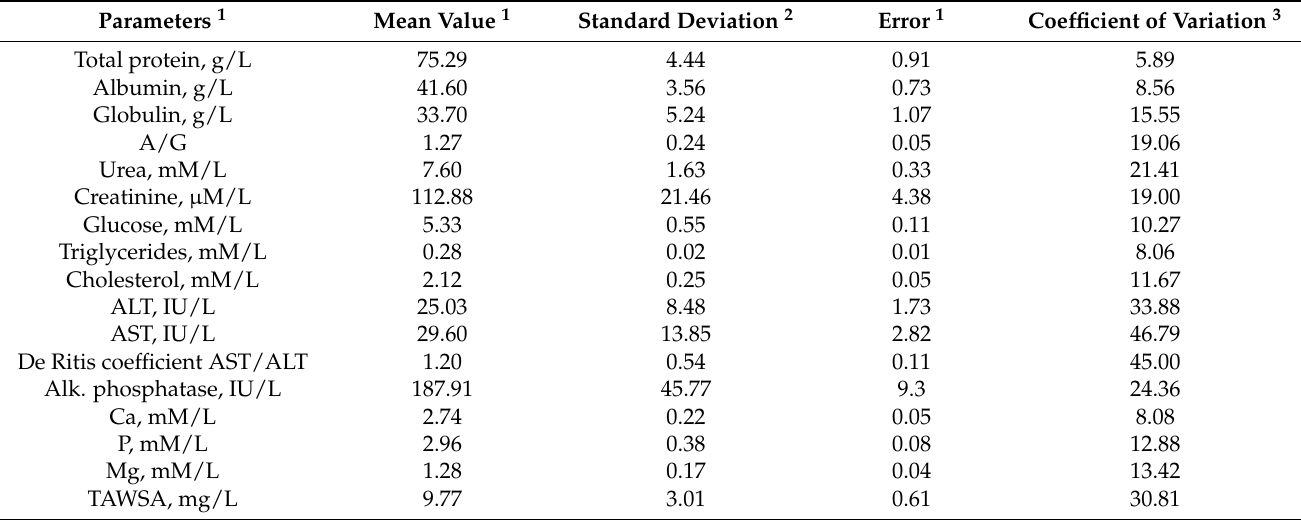
Table 1. Biochemical and antioxidant parameters of the blood serum of the Duroc breed pigs ( n = 25) in group 1 (65 days of fattening).